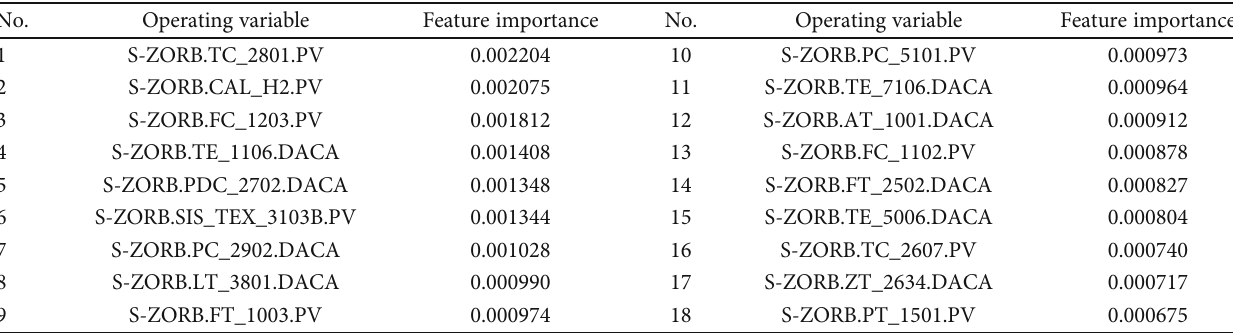
Table 4: Operating variable feature importance of random